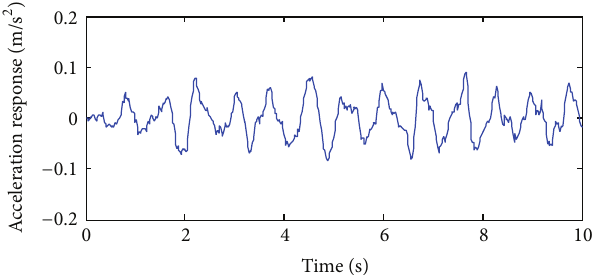
Figure 15: The time series of the accelerometer with noise.